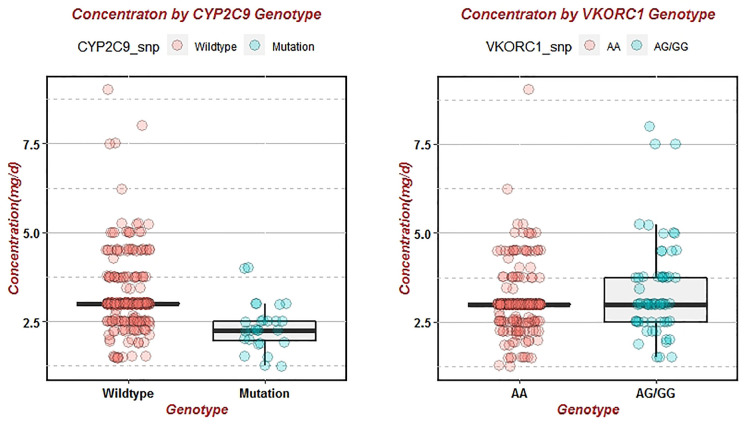
Effects of wild-type and mutant of CYP2C9 and VKORC1 on warfarin stable dose. Variance analysis of warfarin dose in different genotypes was represented by boxplot, and scatter was the true warfarin dose distribution of each patient with different genotypes.